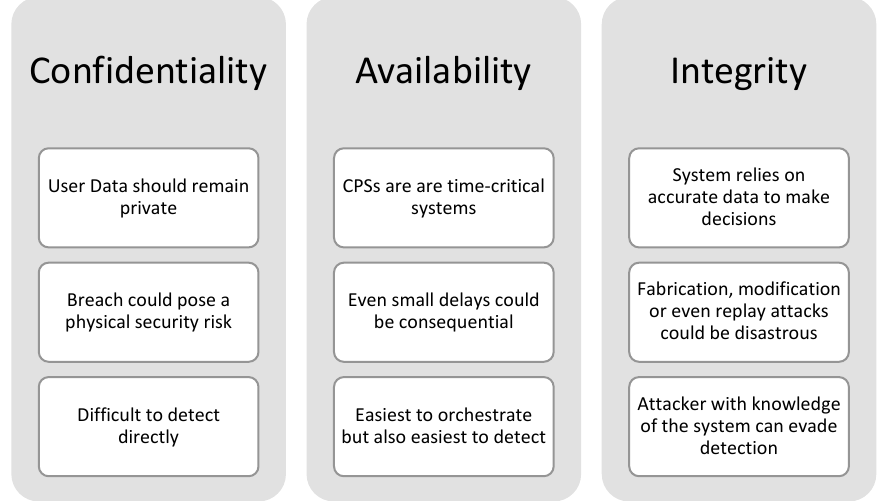
Figure 4. Summary of the three key network security